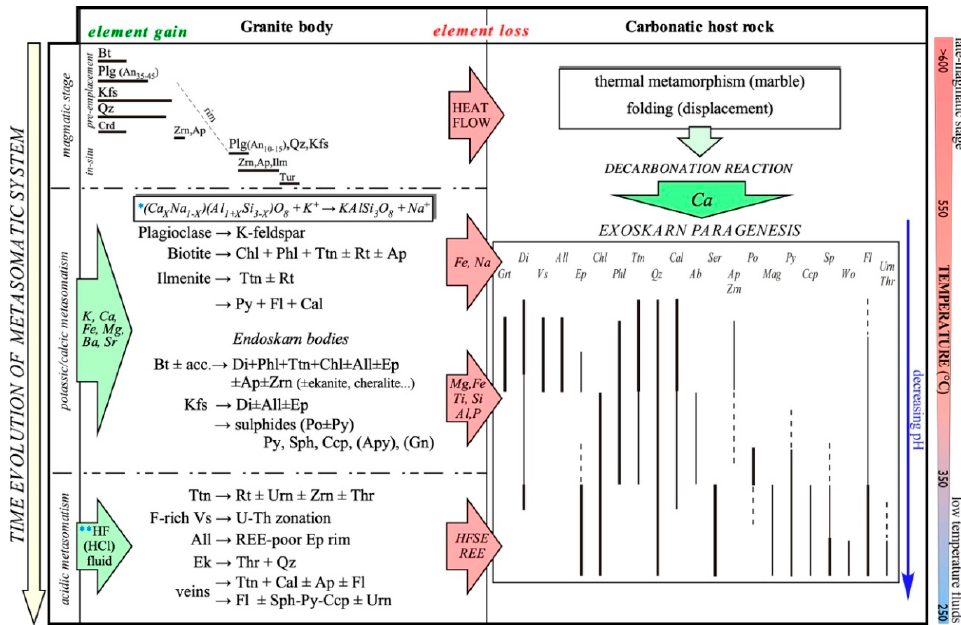
Figure 2. Mineral paragenesis for the original and metasomatic assemblages from the Campiglia system, modified after [1]. *Plagioclase (Plg) rim (An 10–15 ) completely replaced by K ‐ feldspar (Kfs), while the plagioclase core (An 35–45 ) is partially replaced. **calc ‐ silicates dissolution/replacement, HFSE and REE local mobilization, chemical zoning of vesuvianite (Vs), titanite (Ttn), diopside (Di) and garnet (Grt). All = allanite; Ap = apatite; Apy = arsenopyrite; Bt = biotite; Cal = calcite; Ccp = calcopyrite; Chl = chlorite; Crd = cordierite; Ep = epidote; Fl = fluorite; Gn = galena; Ilm = Ilmenite; Phl = phlogopite; Py = pyrite; Po = pyrrhotite; Qz = quartz; Rt = rutile; Sph = sphalerite; Tur = tourmaline; Urn = uraninite; Zrn = zircon. Mineral abbreviations from reference